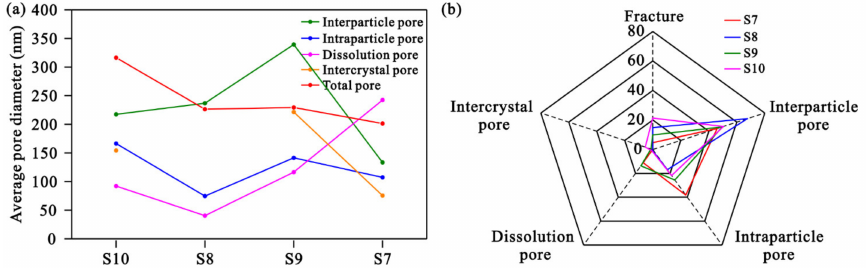
Figure 15. Pore size and type distributions in calcareous shales: ( a ) Average pore diameter; ( b ) Pore type